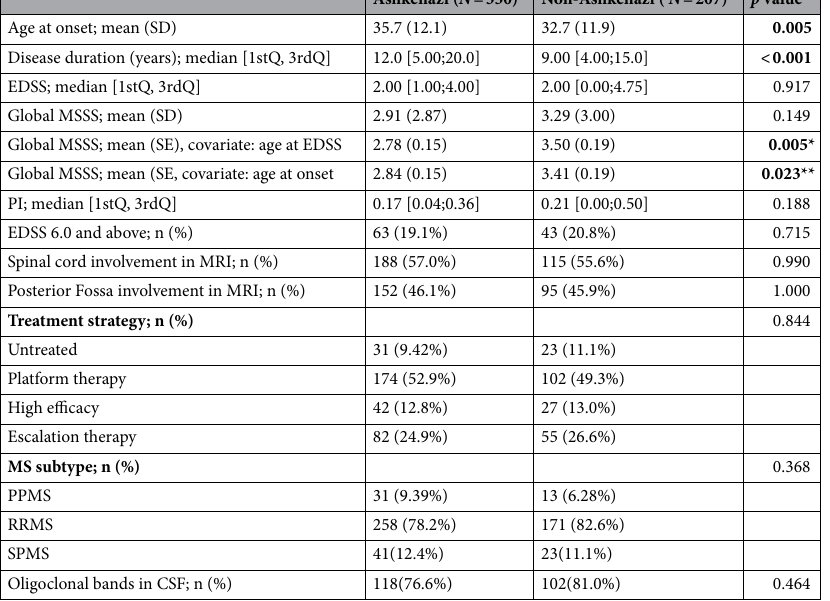
Table 2. Disease phenotype. This table presents the comparison of disease outcomes by ethnic groups. Variables that were normally distributed according to Shapiro test ( p value < 0.05) are presented in the format of mean (SD) and compared using Student T-test. The MSSS was compared using student T-test as accepted for continuous scales in large samples. Non-normal variables are presented by median [1st quartile, 3rd quartile], and compared using Mann-Whitney U test. Categorial variables are compared using Chi-squared test and presented with count (%). p values in bold denote statistical significance (p < 0.05). As post-hoc analysis estimated marginal means (standard error) are presented for MSSS adjusted to covariates using ANCOVA. p values marked by one asterisk (*) are controlled for age at EDSS, while those marked with 2 asterisks (**)